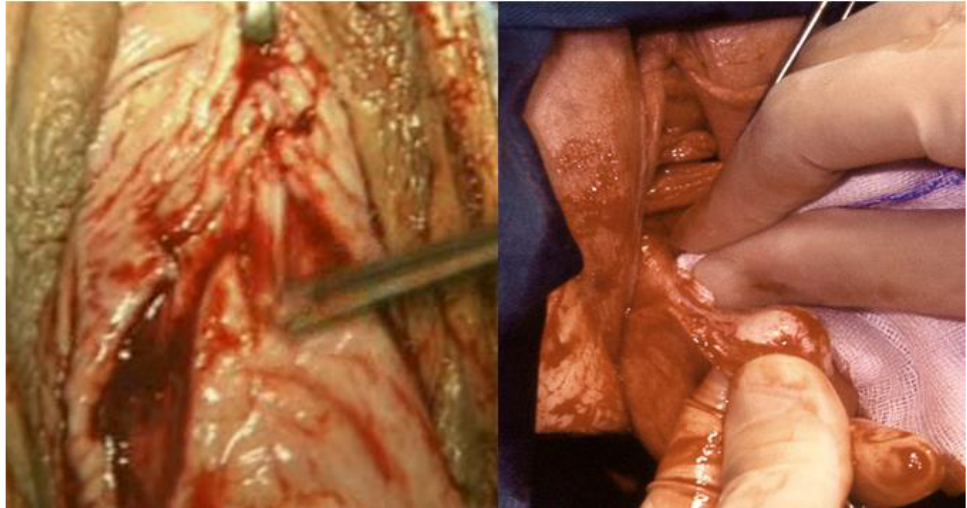
Figure 2. On the left, detaching the bladder away from the uterine wall; on the right, the surgeon ’ s hand holding the gauze separates the bladder from the uterine wall.